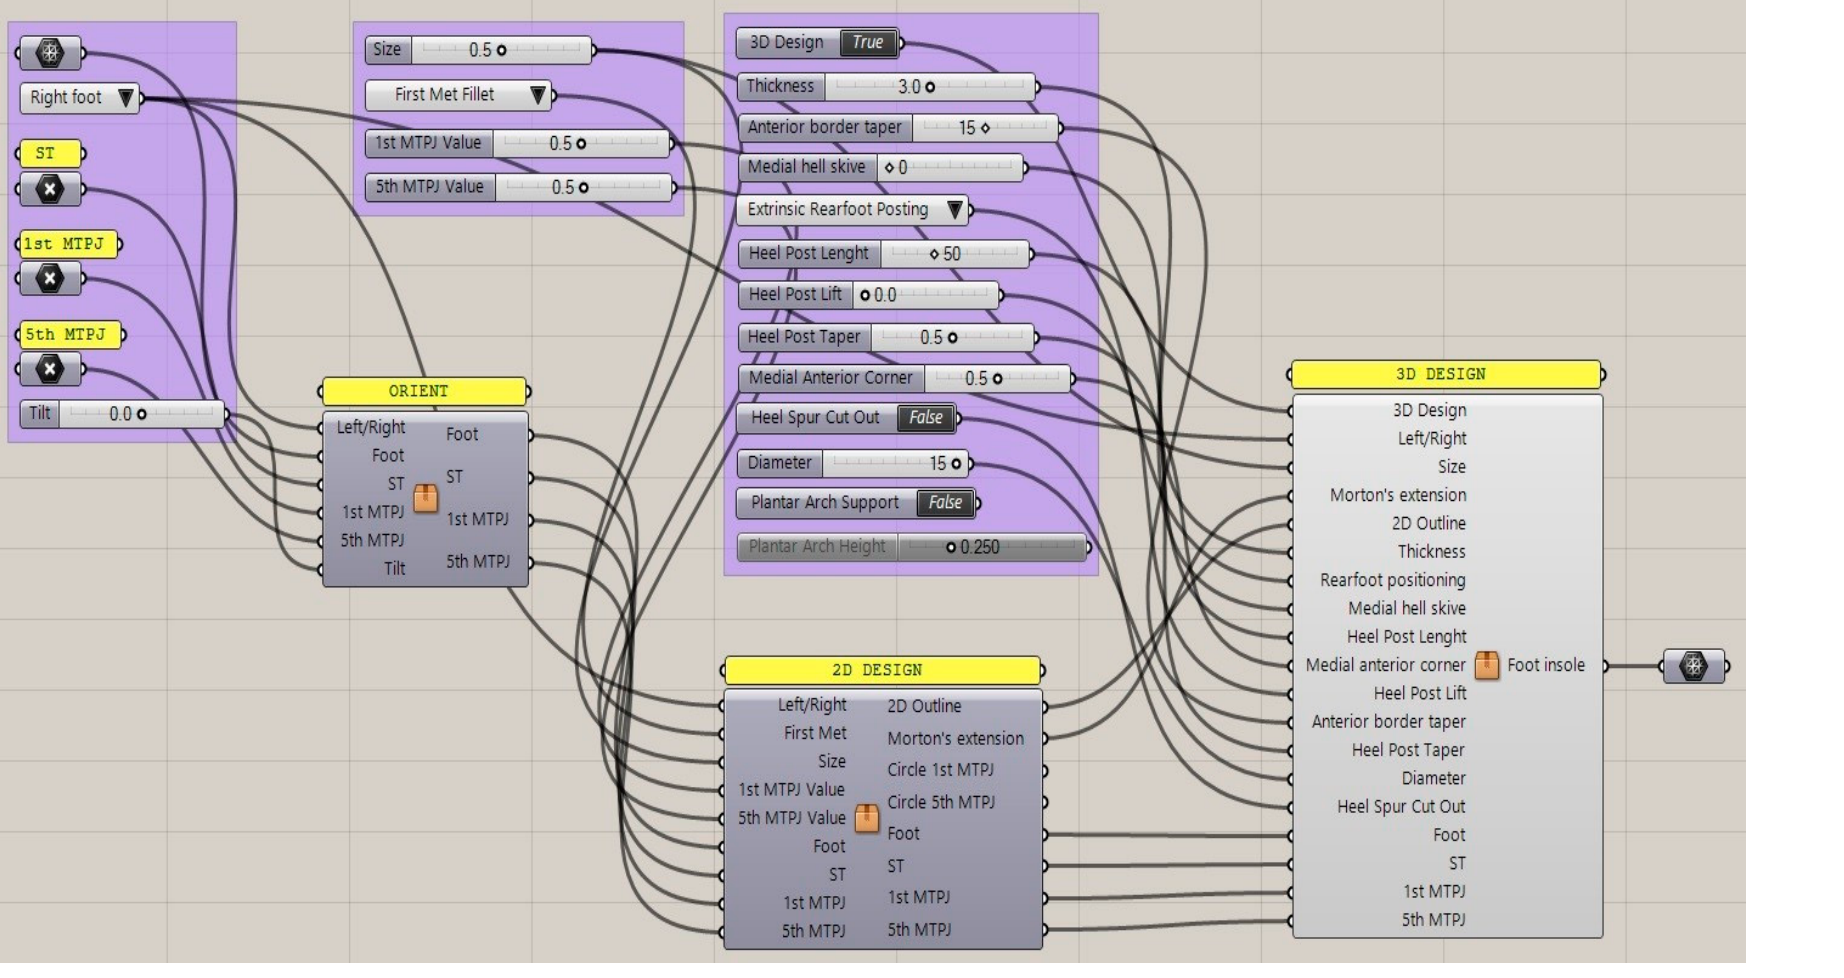
Figure 3. Generative design workflow with input data and sliders of the control panel for interactively modifying the foot orthosis and adding corrections (Grasshopper).